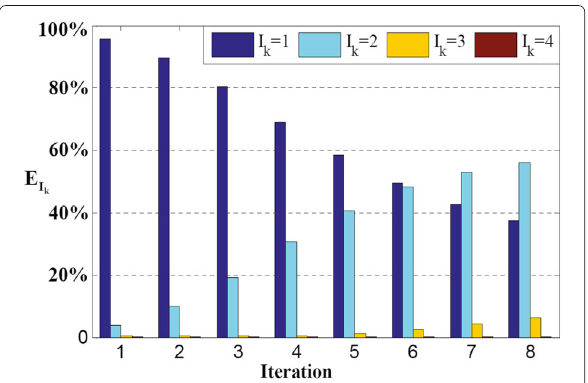
with SNR = 0.9 dB for different k